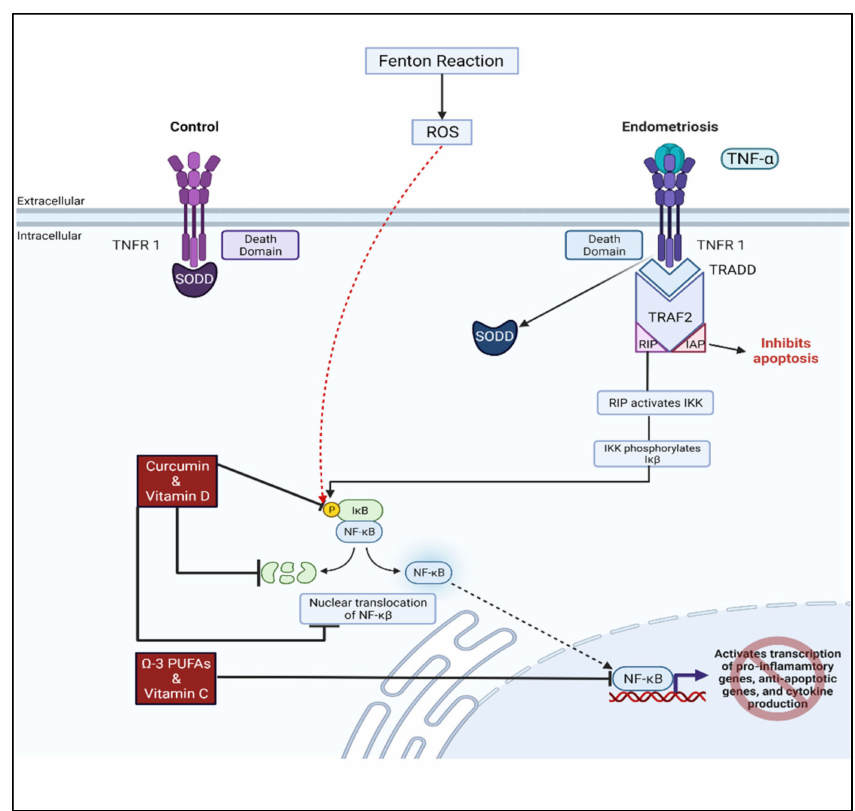
Figure 4. Potential therapeutic options for attenuating oxidative stress and inflammation in en- dometriosis. Elevated levels of TNF-a present in endometriosis activate the TNFR1-dependent signaling pathway which regulates the transcription of genes that prevent apoptosis and promote inflammation and cytokine production. Upregulation of this pathway leads to cell survival, prolif- eration, differentiation, and migration in endometriosis in comparison to controls. Oxidative stress resulting in elevated ROS increases the phosphorylation and degradation of IkB leading to nuclear translocation of NF-kB which activates gene expression. Curcumin and vitamin D supplementation may inhibit the phosphorylation of IkB preventing NF-kB nuclear translocation and expression of downstream targets. Omega-3 PUFAs and Vitamin C have the potential for reducing the activity of transcription factor NF-kB. Adapted from “Intracellular Layout—Nucleus and Endoplasmic Retic- ulum”, by Biorender.com (2022). Retrieved from https://app.biorender.com/biorender-templates (accessed on 18 July